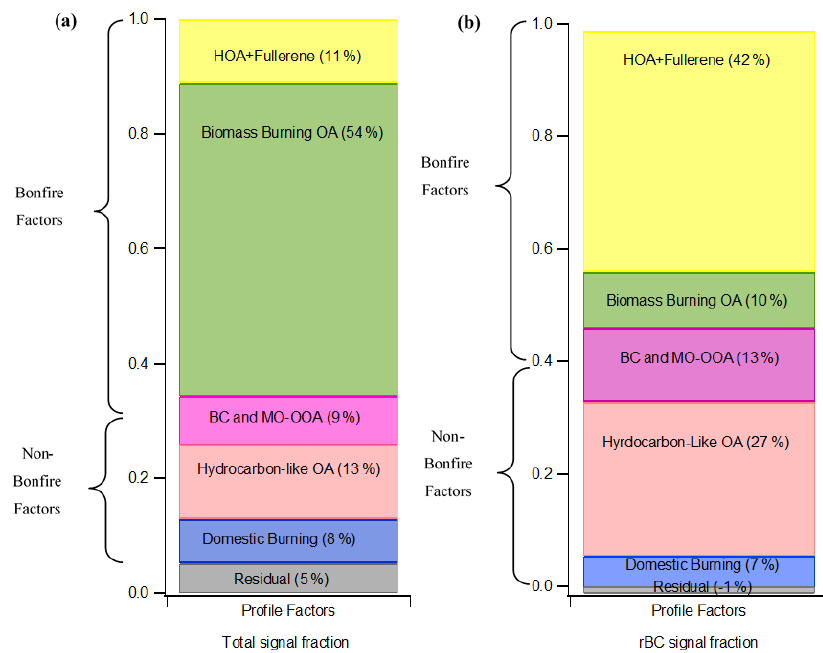
Figure 6. Panel (a) shows the relative contributions of total mass fraction to HR-SP-AMS signal, and (b) shows rBC mass fraction accounted for by each PMF factor.